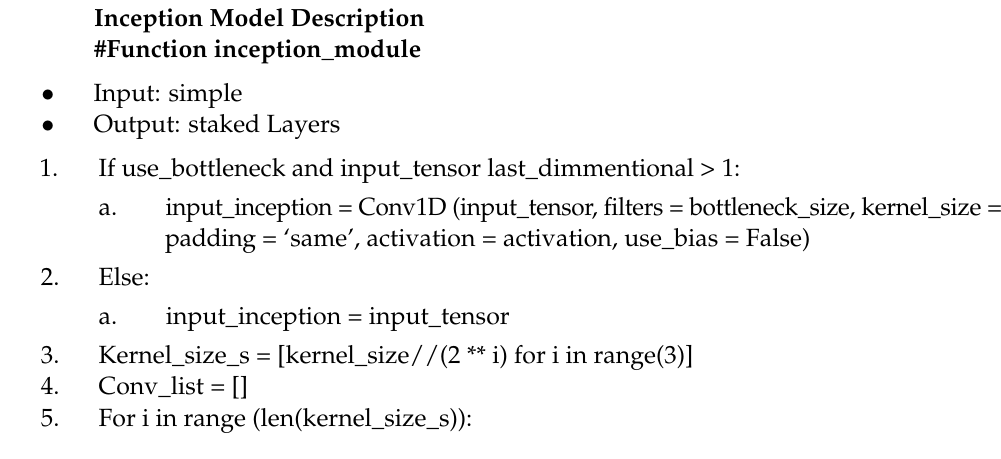
Figure 4. How the input data from the UNSW2015 dataset is turned into window sequences for Inception Time model training using the sliding window technique